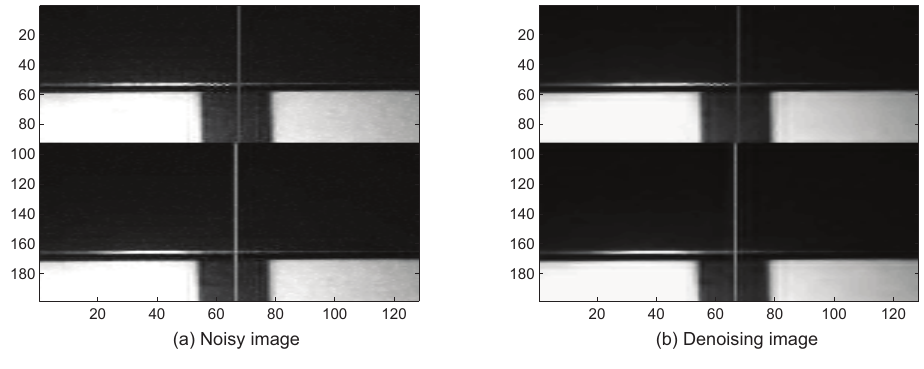
Figure 4. Noisy and denoising image.